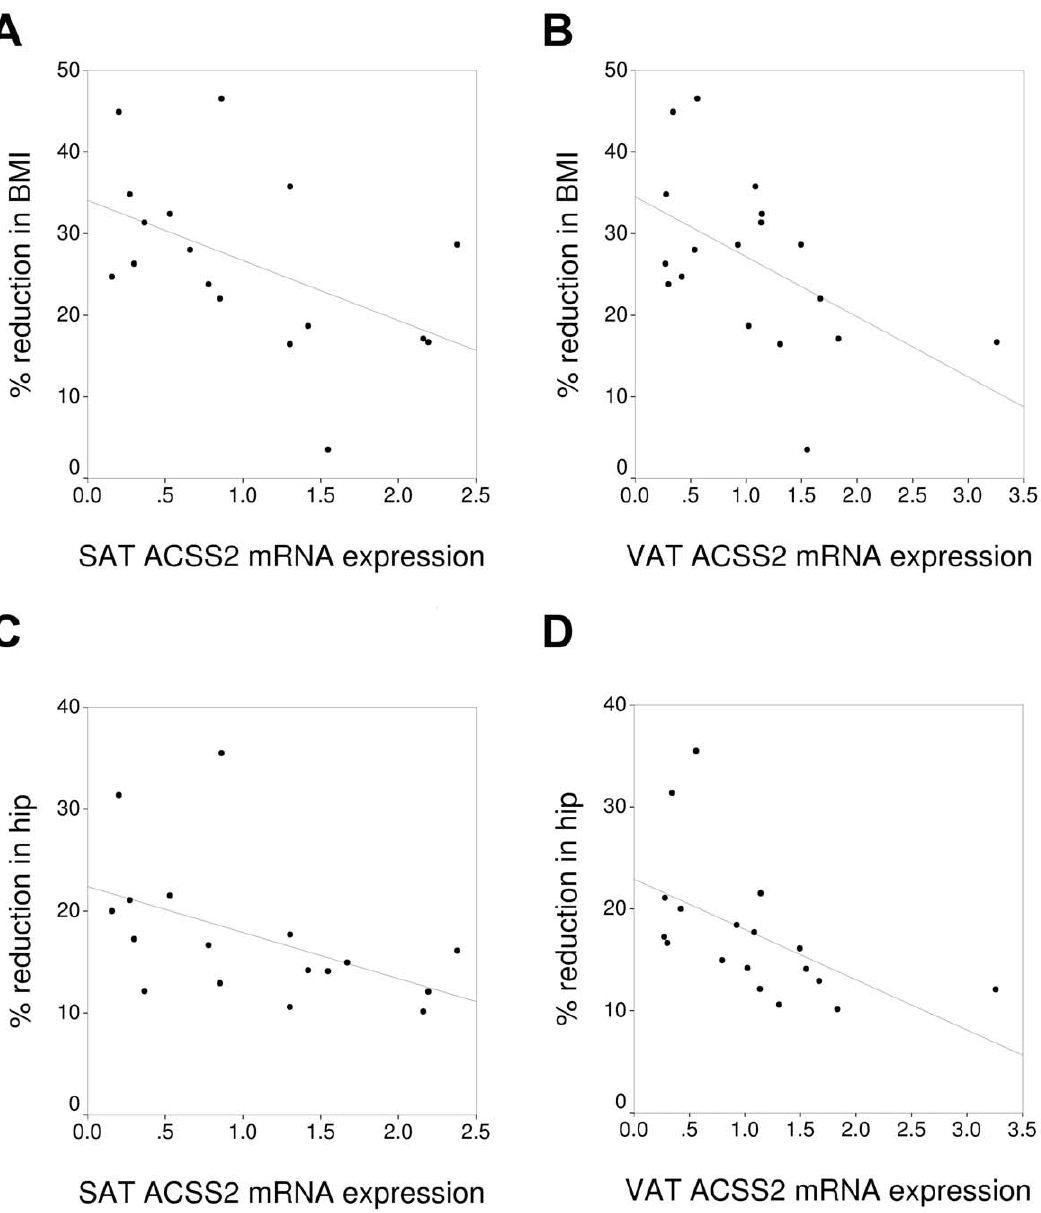
Figure 1. Association between the expression of acetyl-CoA synthetase 2 (ACSS2) and the percentage of reduction in the body mass index (BMI) in subcutaneous (A) and visceral adipose tissue (B), and the hip circumference in SAT (C) and VAT (D). BMI: body mass index.